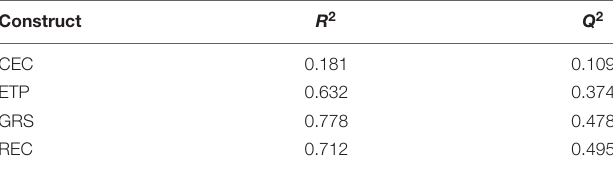
TABLE 6 | Coefficient determination ( R 2 ) and Stone–Geisser test ( Q 2 ).